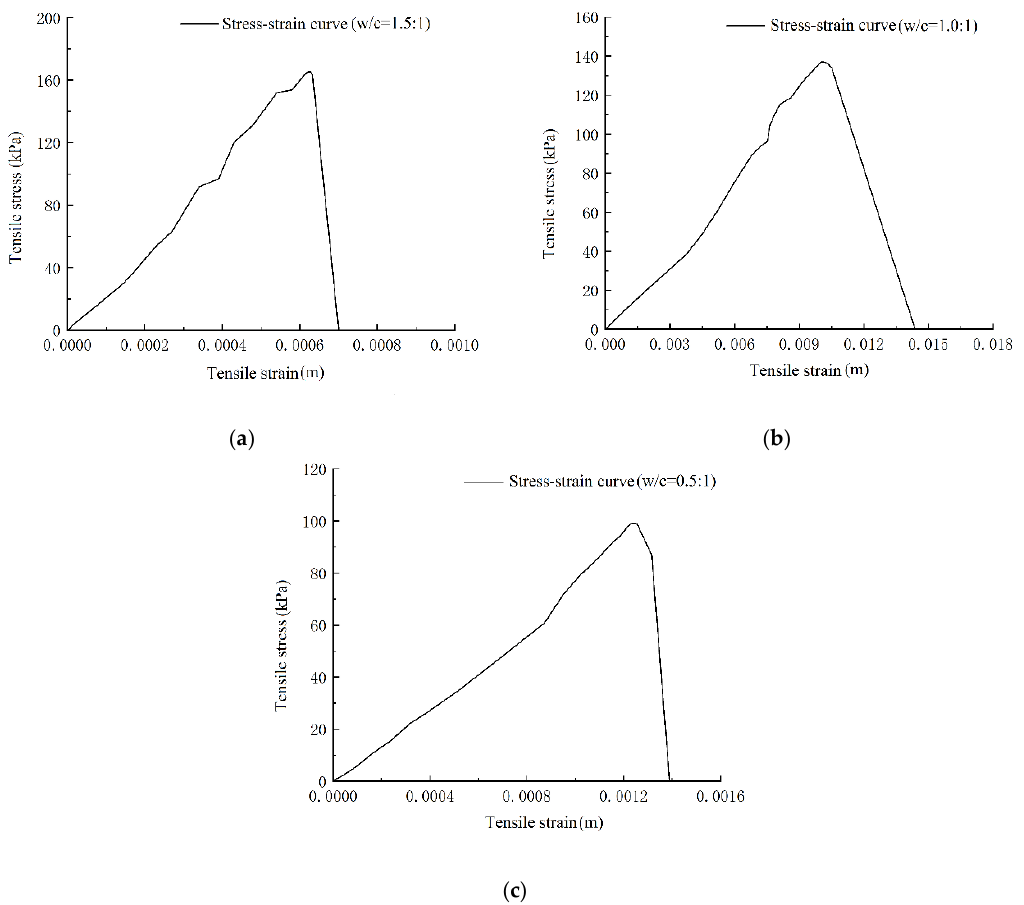
Figure 6. Tensile stress–strain curves of grout at different water–cement ratios of ( a ) 1.5:1, ( b ) 1:1, and ( c ) 0.5:1.